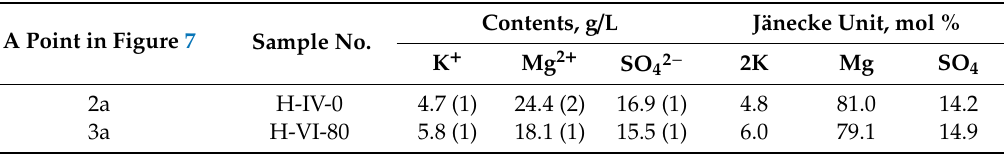
Table 3. Chemical composition of brines collected from the early diagenetic fluid inclusions of halite. The numbers of fluid inclusions are given in